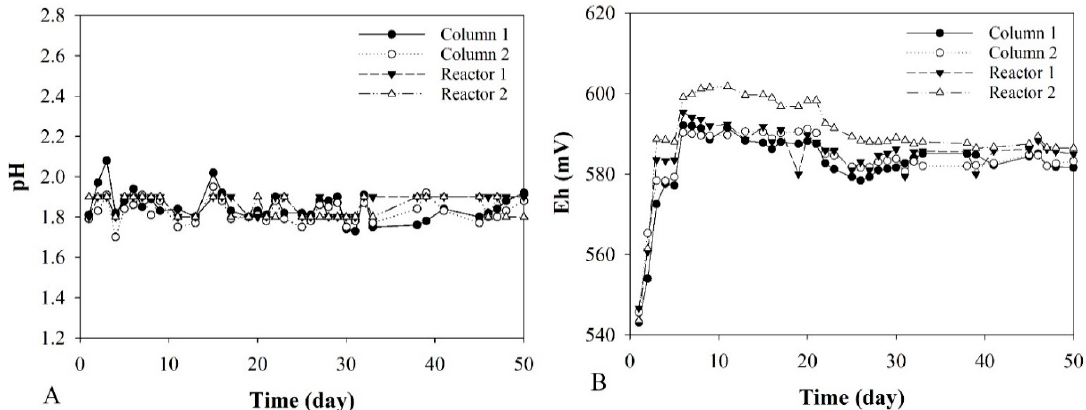
Figure 7. pH ( A ) and Eh ( B ) behavior of the columns and stirred reactors leaching